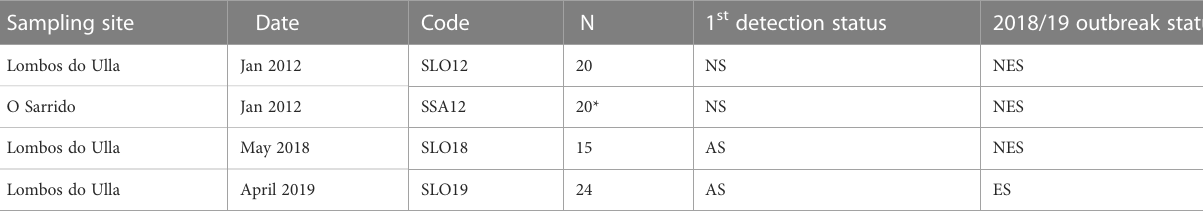
NS and AS: naive (samples collected before 1 st marteiliosis detection) and affected (samples collected after six years of marteiliosis outbreaks), respectively; NES and ES: non-exposed (samples collectedbeforedetectionofthe2018/19marteiliosisoutbreak)andexposed(samplescollectedduringthe2018/19marteiliosisoutbreak),respectively.*Twoindividualswerediscardedfromthis sample after 2b-RAD fi ltering, totalling 18 individuals for